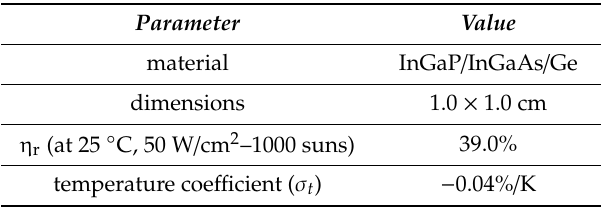
Table 1. Parameters of the triple-junction